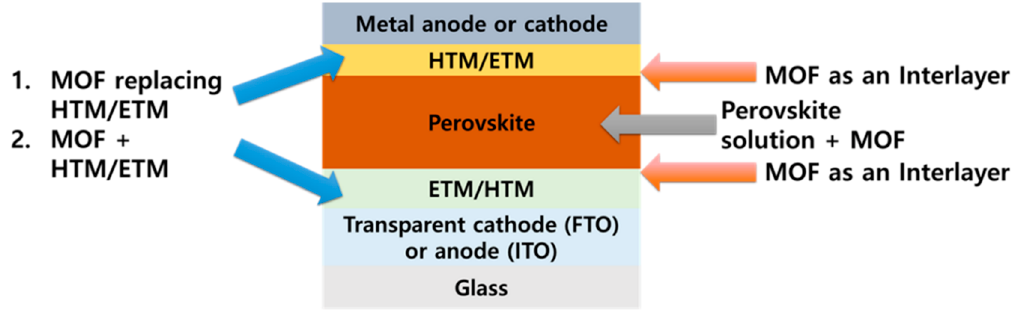
Figure 7. Schematic of where MOFs can be used in perovskite solar cells